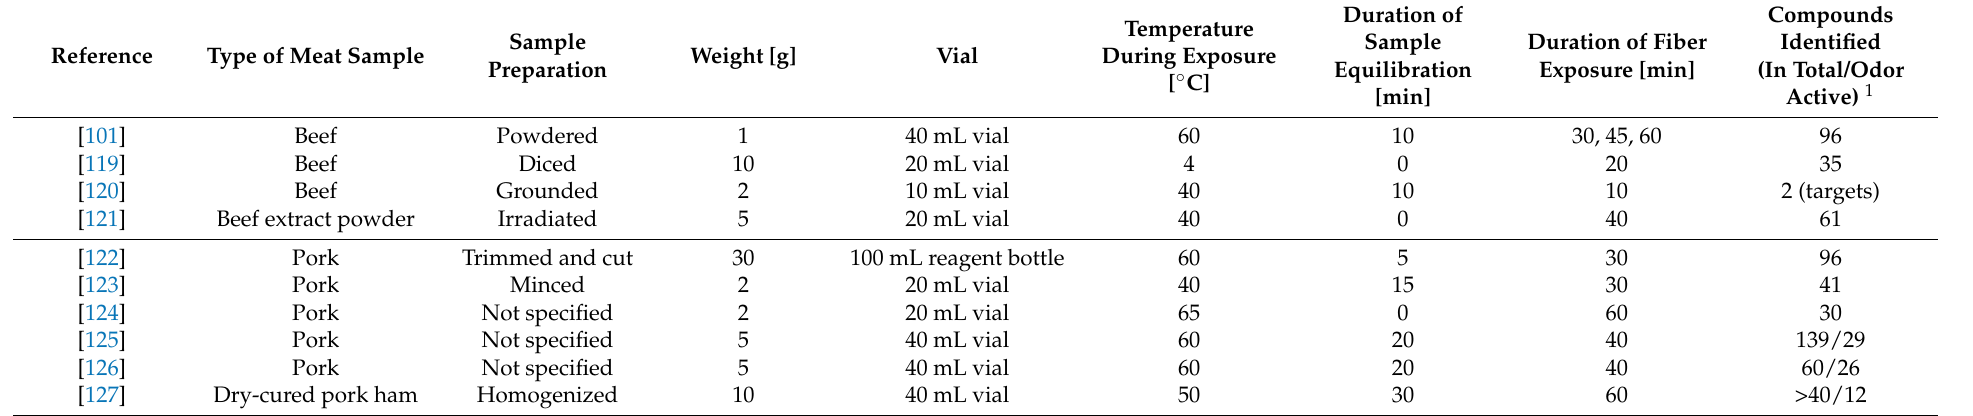
Table 3. Conditions of the analysis of VOCs in meat via SPME applied in ten research articles on the